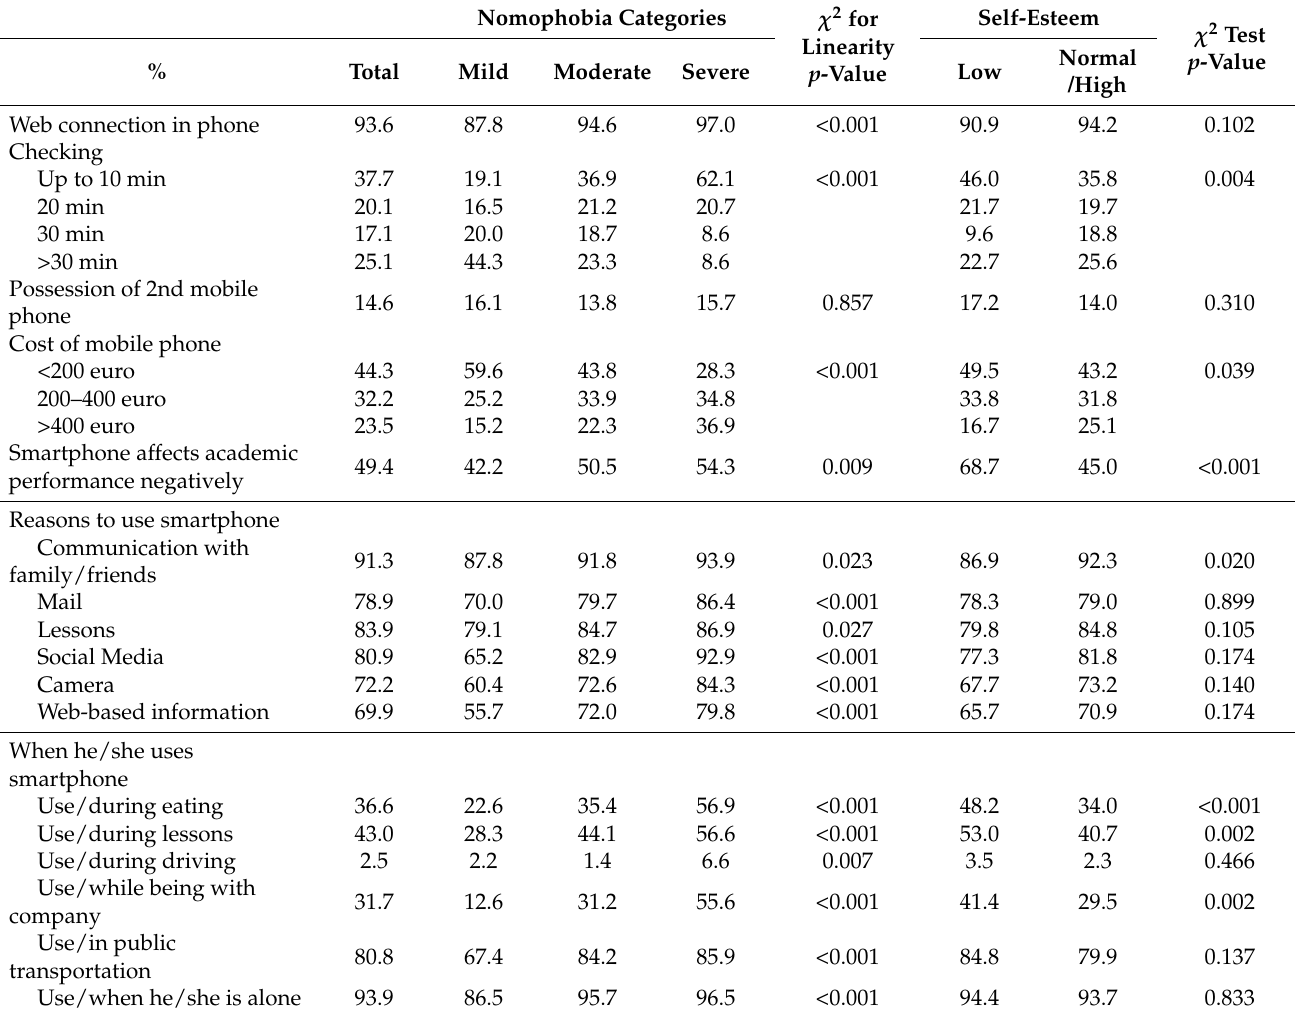
Table 2. Mobile phone use in percentages according to NMP and self-esteem